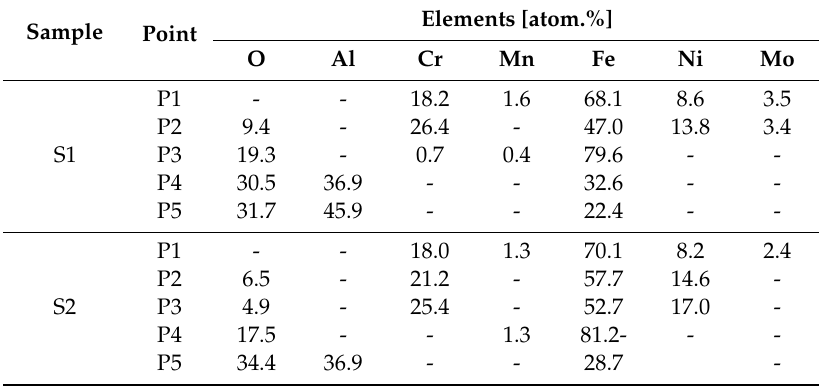
Table 4. EDS results on selected points in the sample sections.